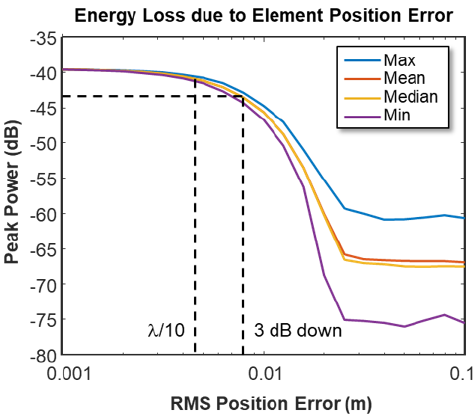
Figure 14. Power loss with position error simulated based on 33 kHz sonar